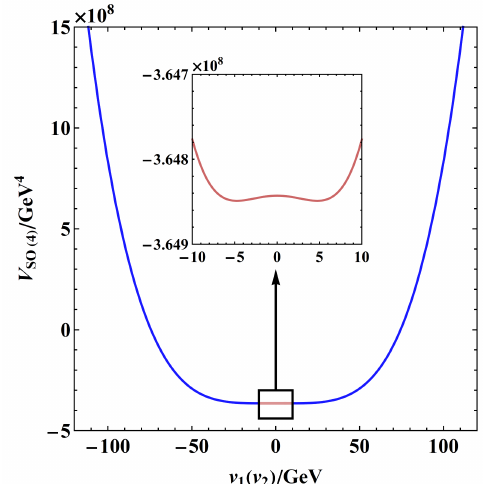
along the v direction (assuming SO(4) 1(2) = 2 . 421 × 10 4 GeV 2 , m 2 = 1 . 563 × 11 H = − 0 . 527 , respectively. Notice that v is fixed at its 14 H